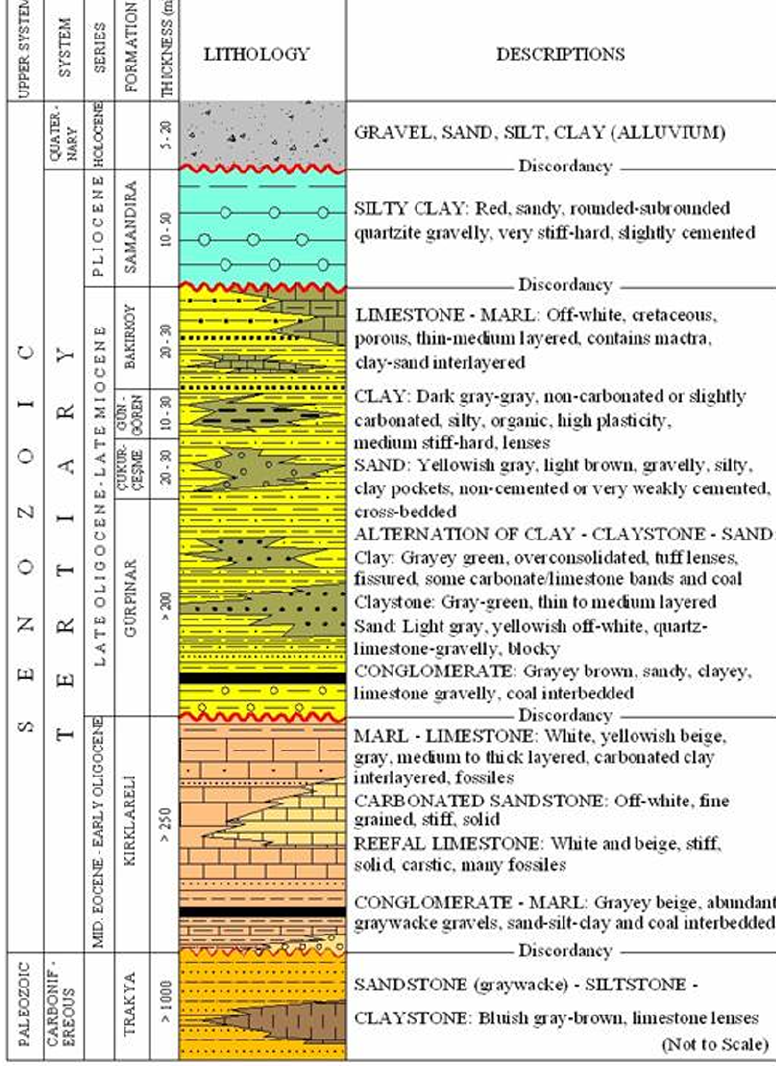
Fig. 7. Stratigraphy of the Tertiary Deposits of Istanbul city and its Vicinity (Yıldırım and Savas¸kan, 2003).